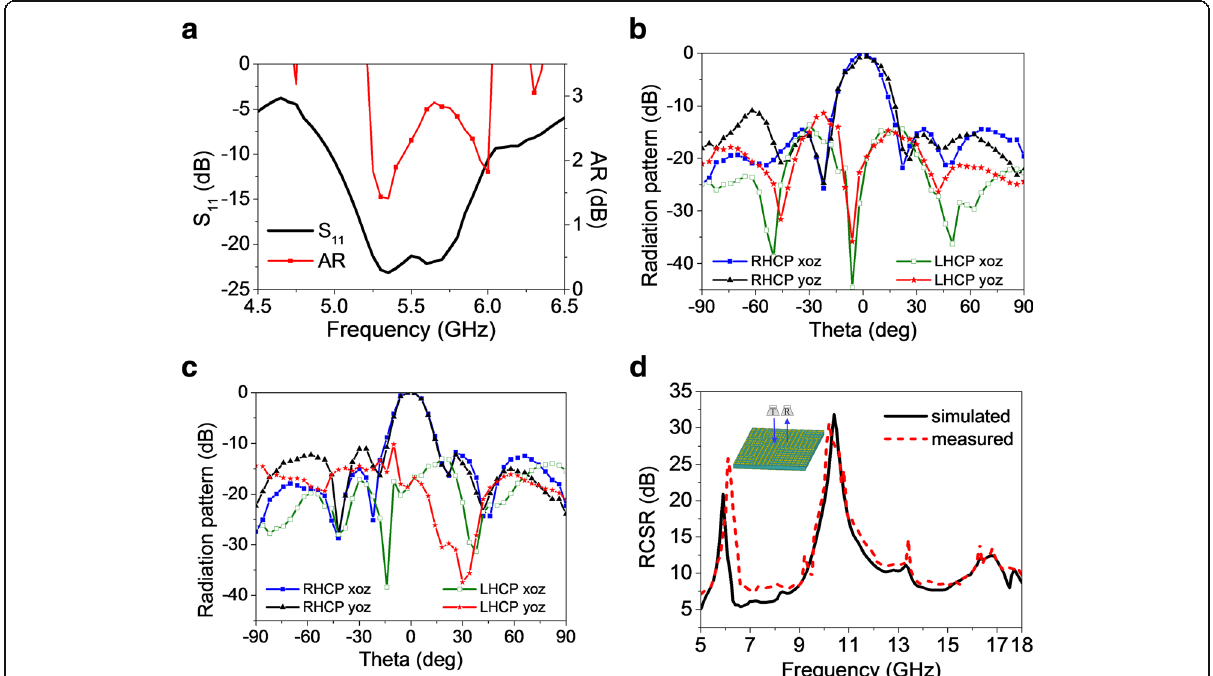
Fig. 13 Measured radiation and scattering properties of the EMMS. a Measured S 11 and AR. Normalized radiation patterns at 5.35 GHz ( b ) and 5.75 GHz ( c ). d Measured reflection reduction of the EMMS compared to full metal board